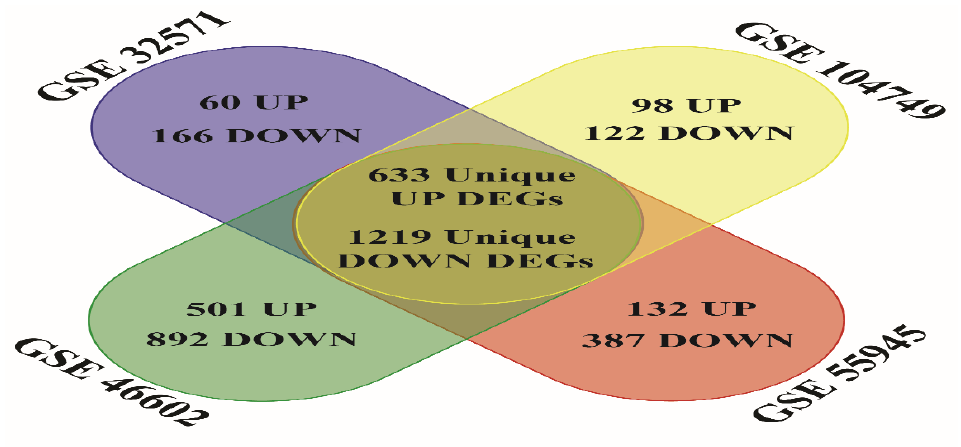
Figure 3. A plot depicting the upregulated-downregulated & unique DEGs discovered in four datafiles GSE32571, GSE104749, GSE46602, GSE55945. Statistically significant DEGs were characterized by the cut-off criterion of log2FC value > 1, log2FC value < − 1 and p <